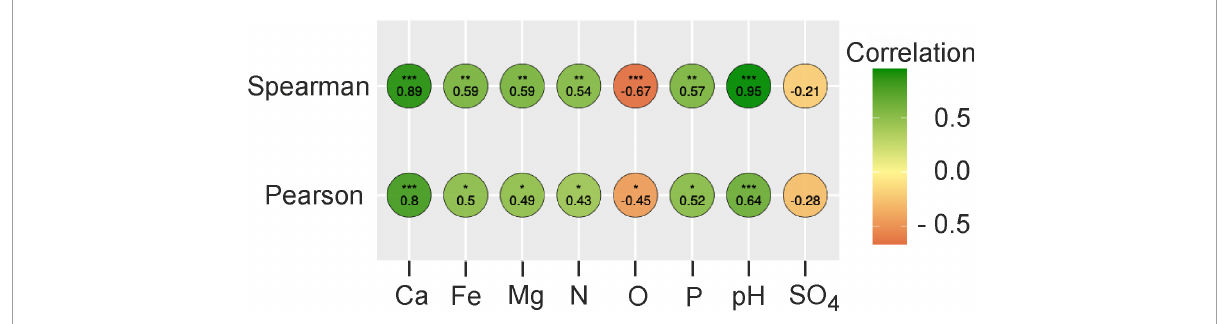
FIGURE1 The correlation matrix based on Spearman’s and Pearson’s correlation analysis between peat chemistry and relative abundances of MBNT15. The color of circles represents the correlation strength. Significant correlations are indicated by asterisks; adjusted p-value confidence level * < 0.05; ** < 0.01; *** < 0.001. N, total nitrogen; O, organics; P,